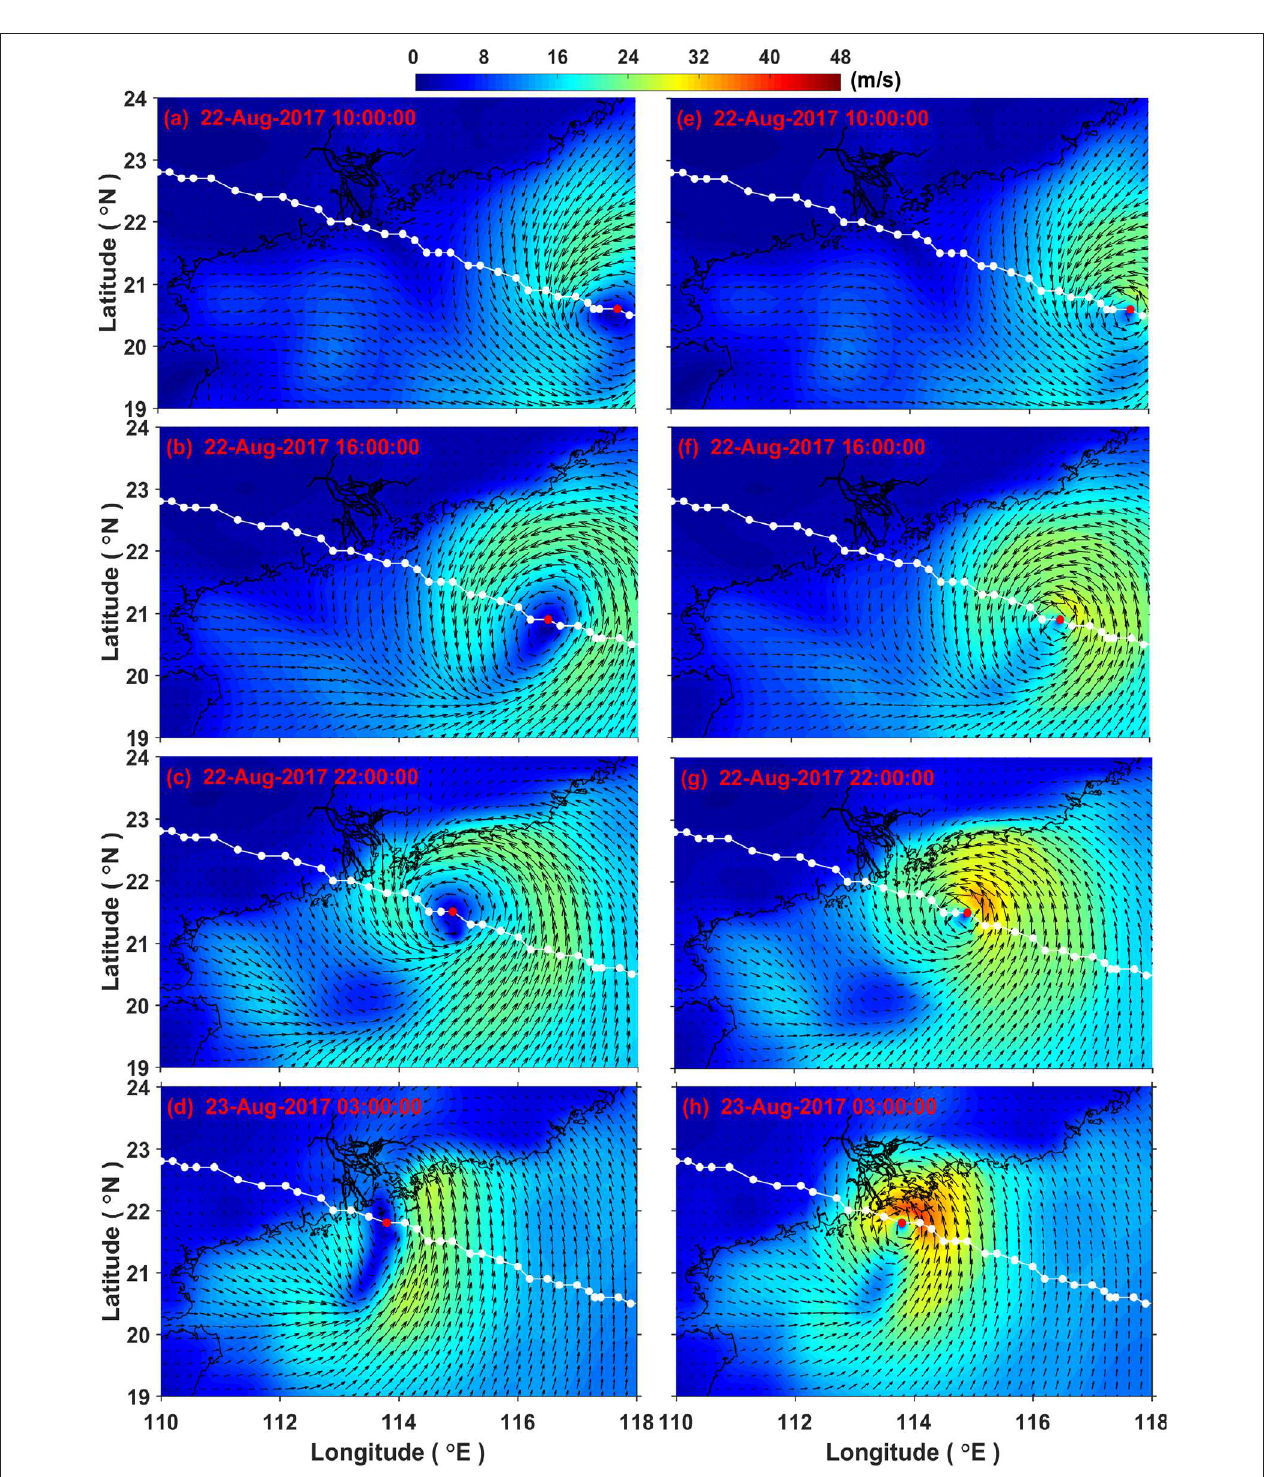
FIGURE 2 | Wind fields from the CFSR dataset (a–d) , CFSR, and Holland model blended data (e–h) from 10 GMT on August 22 to 03 GMT on August 23, 2017, when Typhoon Hato moved over the northeastern part of the South China Sea. The white (red) solid circles represent the non-current (current) position of the hourly typhoon center provided by Zhejiang Water Resources Department (typhoon.zjwater.gov.cn ).